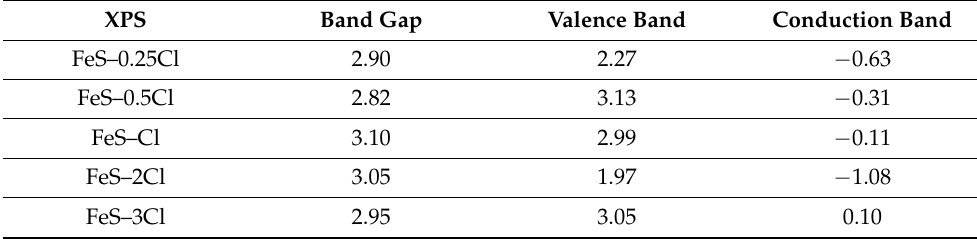
Table 4. Band gap, valence band and conduction band sulphide